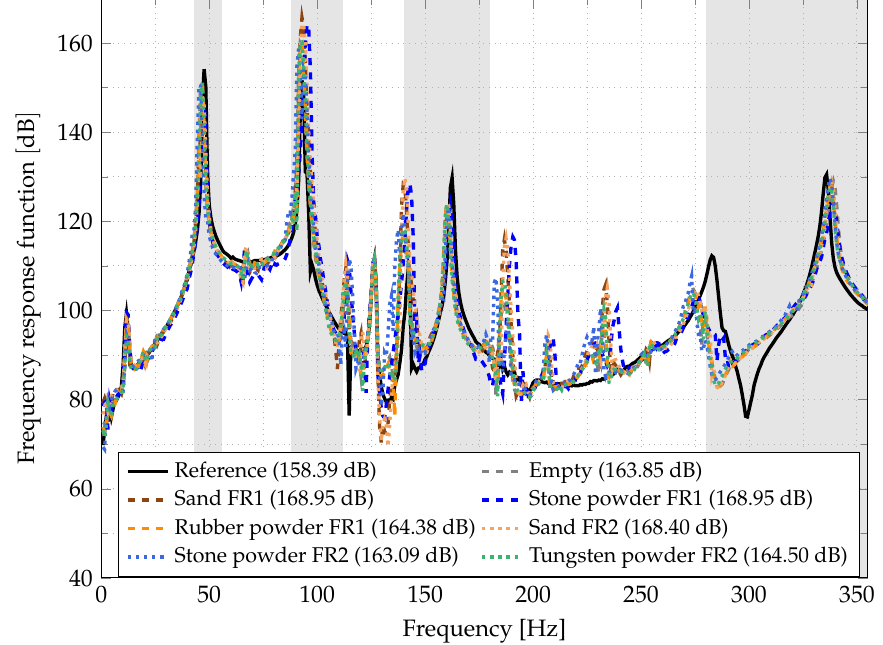
Figure A3. Narrow band spectrum representation of FRF of WTS test specimen. SU HCDP mounted to the outer wall of the stator ring (opposite to the excitation point). SL of surface velocity is given in dB.